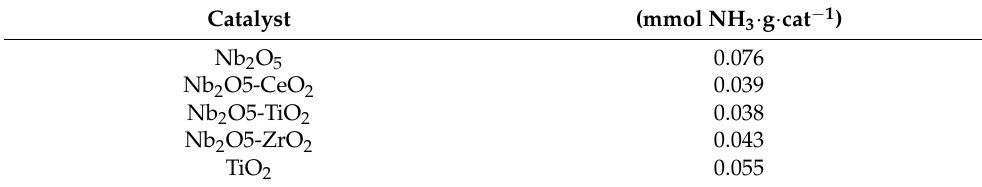
Table 2. Total acidity of the prepared catalysts determined by NH 3 -TPD